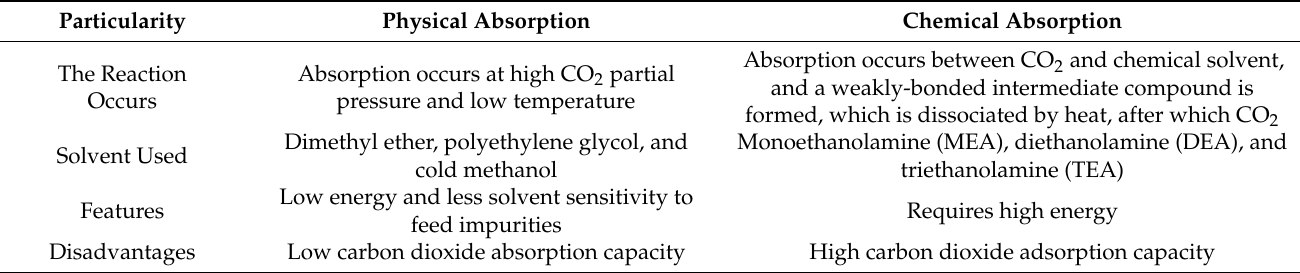
Table 1. Physical and absorption chemical